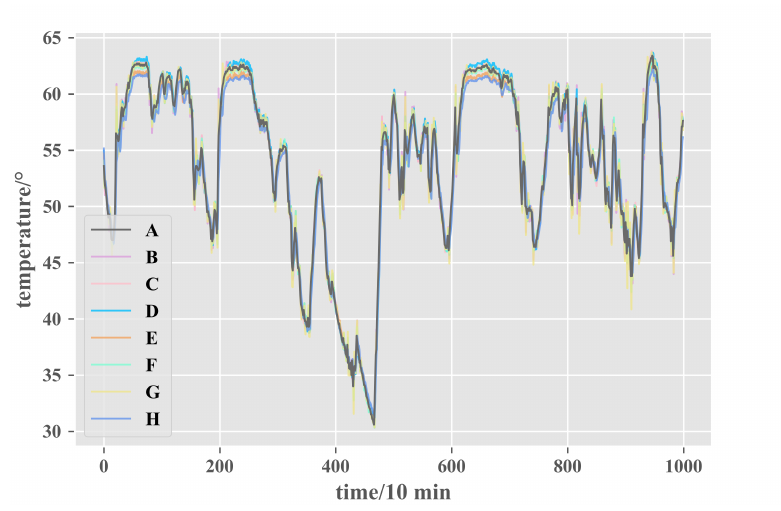
Figure 7. The comparison of different models for gearbox oil temperature prediction in wind #2.